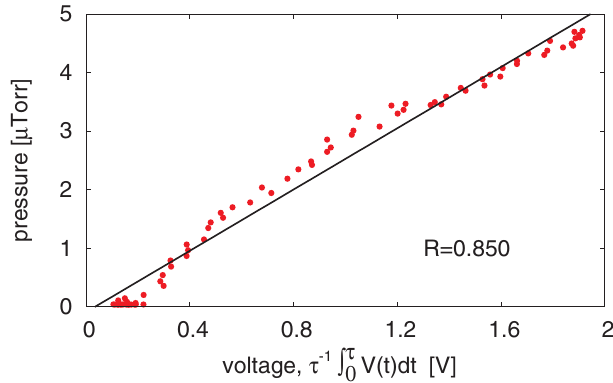
FIG. 7. (Color) Linear fit (black line) to the experimental data (red points) from Fig. 6. The fit includes the data until the beam is dumped. The linear relation between the pressure and the ED is confirmed, in this case, for unbaked stainless steel voltage h V i (cid:3) surface.